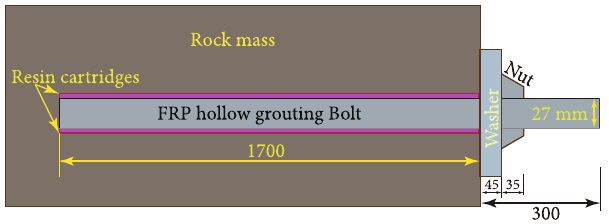
Figure 6: Schematic of anchor